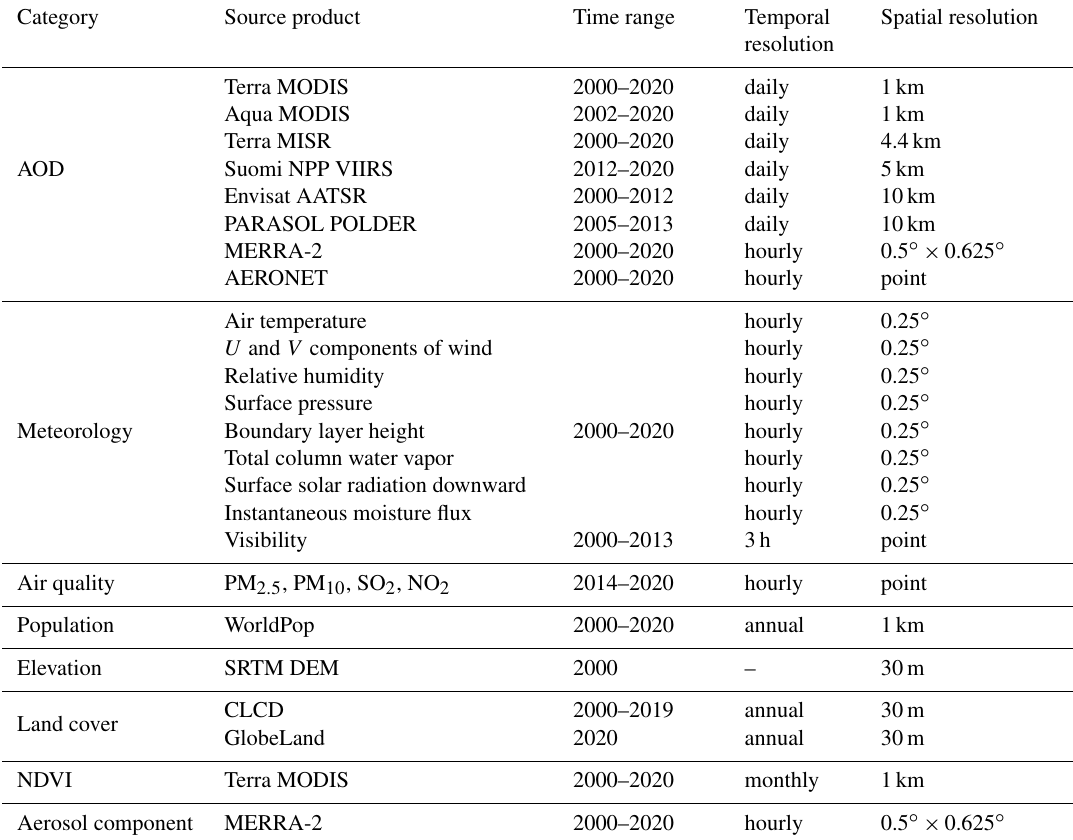
Table 1. Summary of the data sources used in this study to generate gap-free high-resolution AOD and PM x concentration datasets. NDVI denotes the normalized difference vegetation